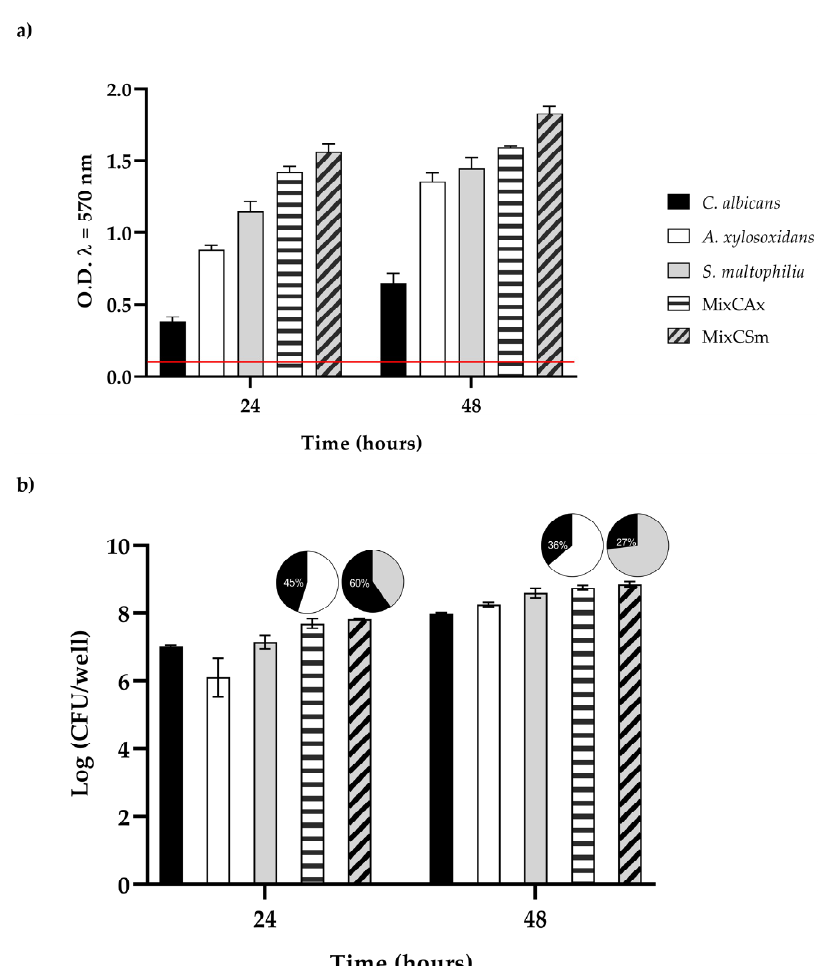
Figure 3. ( a ) Biofilm formation capacity of C. albicans , A. xylosoxidans , S. maltophilia , and the two mixed biofilms ( CAx , CSm ) using the crystal violet staining method. Red line represents ODcut. ODcut = mean of negative control with addition of 3 times the SD. ( b ) Enumeration of colony forming units per well for single- and dual-species biofilms.